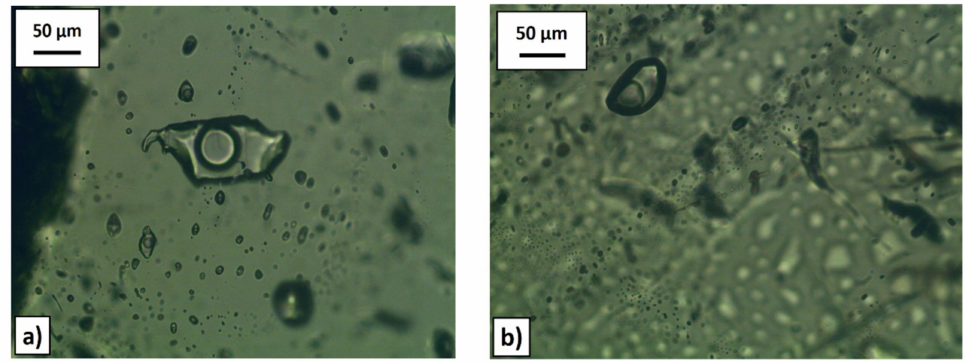
Figure 8. ( a ) Isolated bi-phasic primary fluid inclusions with a size of over 100 µ m (sample SHS2, objective 5 × ). Other primary isolated fluid inclusions (back and front of the big isolated fluid inclusions) and intra-granular trails of pseudo-secondary fluid inclusions. ( b ) Isolated fluid inclusions in a negative-crystal shape (sample SHS1, objective 50 × ). Primary negative-crystal shape fluid inclusions and pseudo-secondary oval-shaped fluid inclusions in intra-granular trails are observed in the back side.